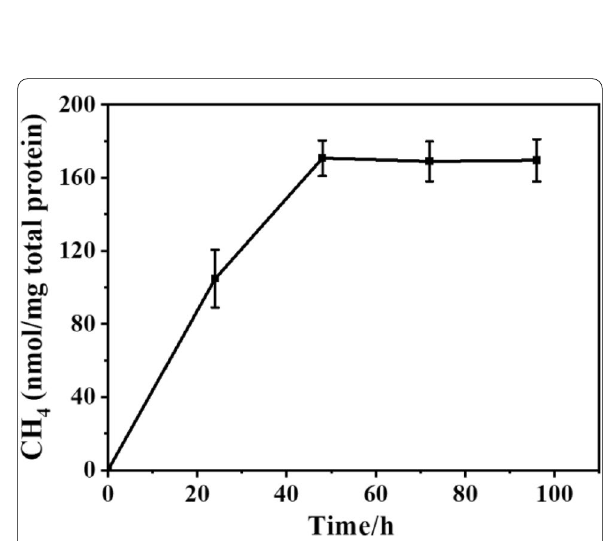
Fig. 5 The biomethanation performance of RP/CdS hybrid cells under the optimized conditions (OD660 0.1, sodium = bicarbonate 2 mM, L‑Cys 14 mM, light intensity 5000 = = =